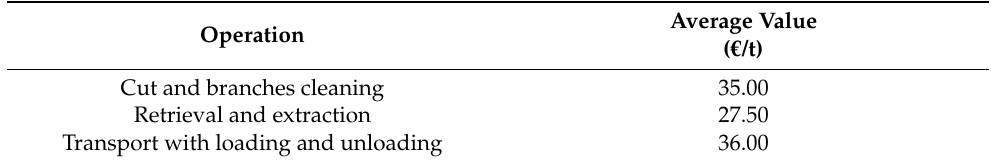
Table 7 (adapted from http://www.icnf.pt, accessed on 20 December 2021) for reference costs for forestry work. Table 7. Forestry operations reference costs map (adapted from www.icnf.pt, accessed on 20 December